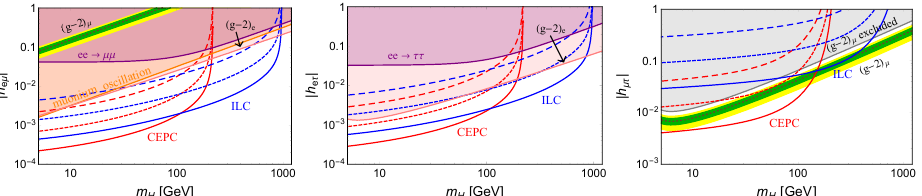
Figure 3. Prospects of LFV couplings | h e µ | ( left ), | h e τ | ( middle ), and | h µτ | ( right ) from the process (2) at CEPC 240 GeV with 5 ab − 1 (red) and ILC 1 TeV with 1 ab − 1 (blue). A branching ratio of 1% (long-dashed), 10% (short-dashed), or 100% (solid) from H decay is assumed to be visible. The shaded regions are excluded by the corresponding limits. In the left and right panels, the brown line could fit the central value of ∆ a µ , and the green and yellow bands cover the 1 σ and 2 σ ranges of ∆ a µ . See text for more details. Figure from Ref.